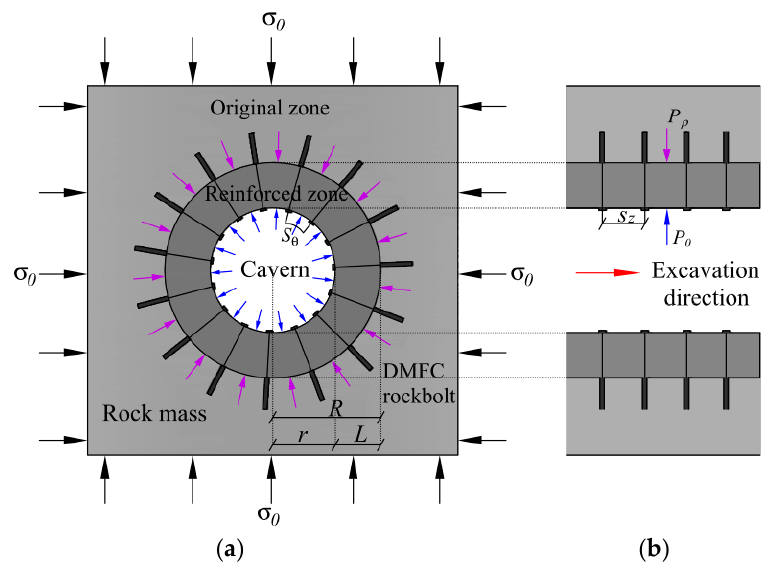
Figure 1. Geometric model of discretely mechanically or frictionally coupled (DMFC) rockbolts and rock mass: ( a ) plane direction; ( b ) excavation direction.